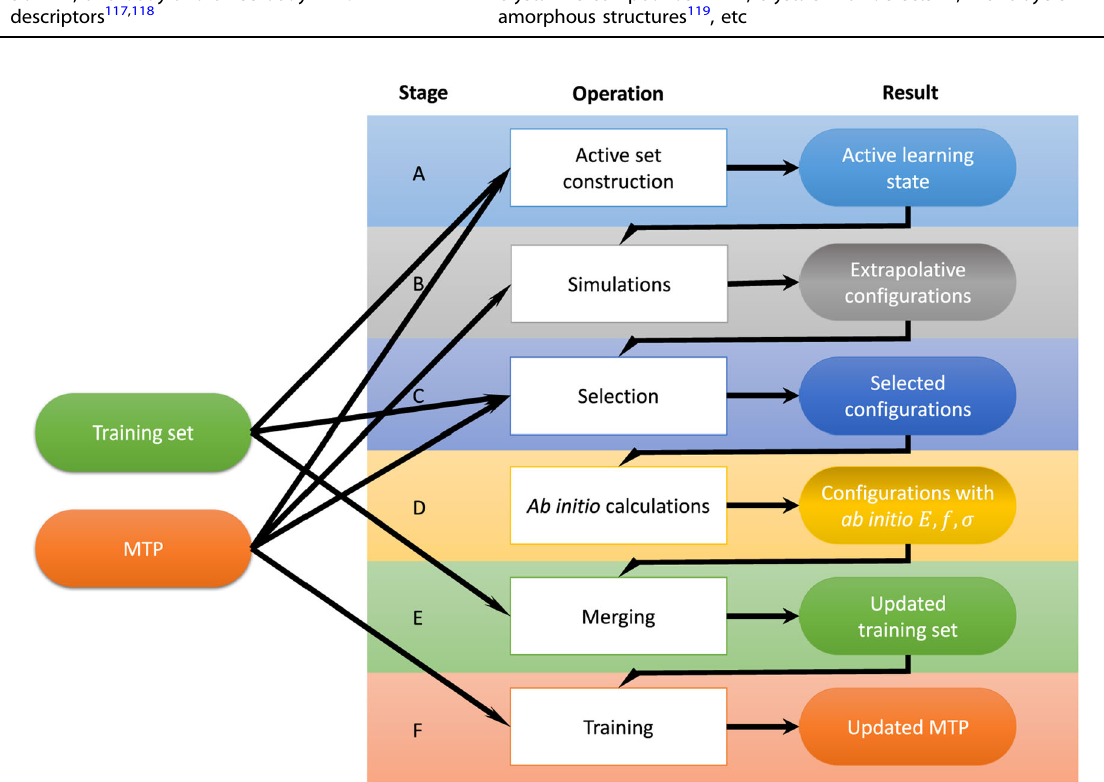
Fig. 4 Scheme of active learning bootstrapping iterations for training the Moment Tensor Potential (MTP). By selecting extrapolative con fi gurations from the MD trajectories, the MTPs are trained in a loop until simulations are fi nished without exceeding the allowed maximum of extrapolation grade. Reproduced with permission from ref. 94